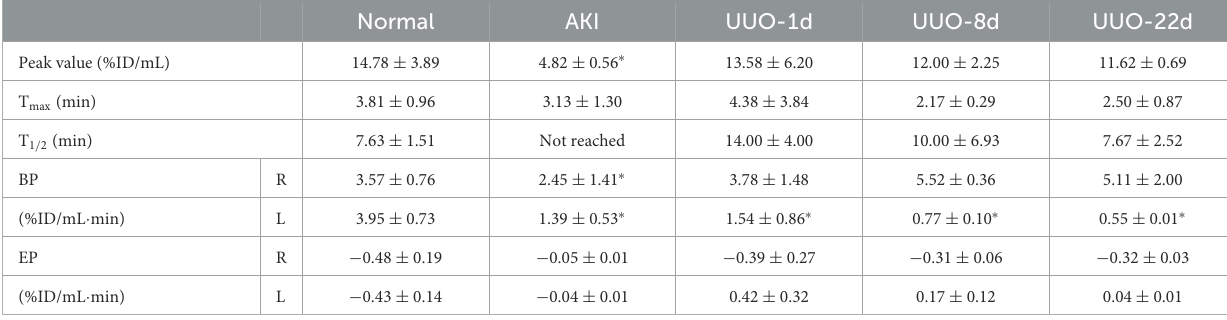
TABLE 1 Renogram information.